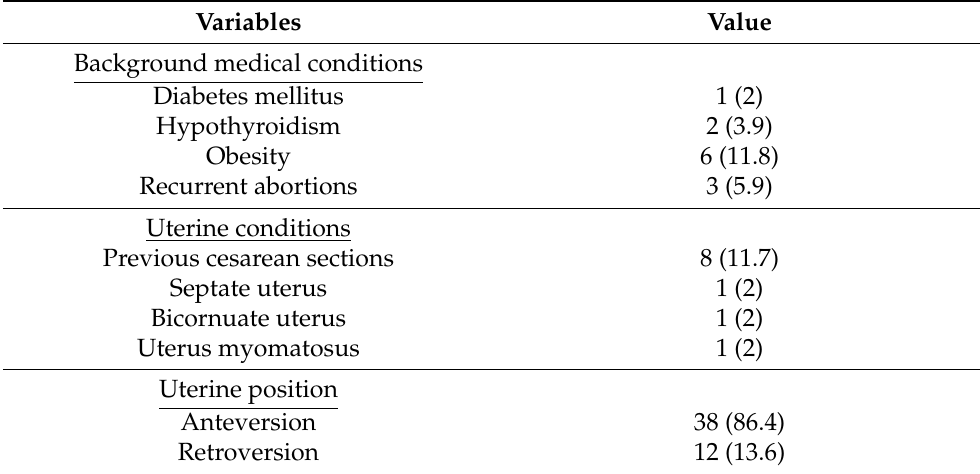
Table 3. Background and uterine condition characteristics for patients who delivered following perforation of uterus.